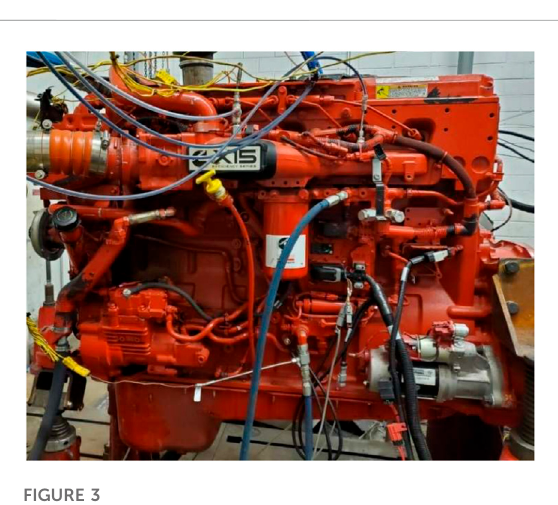
FIGURE 3 Cummins X15 engine platform installed in test